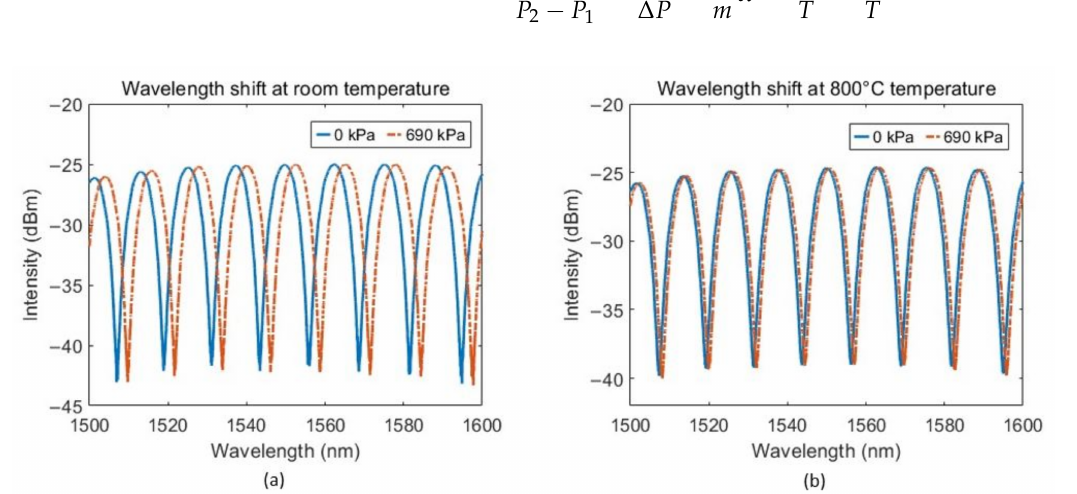
Figure 4. Reflection spectra for two different pressure levels at ( a ) room temperature and ( b ) 800 °C temperature.